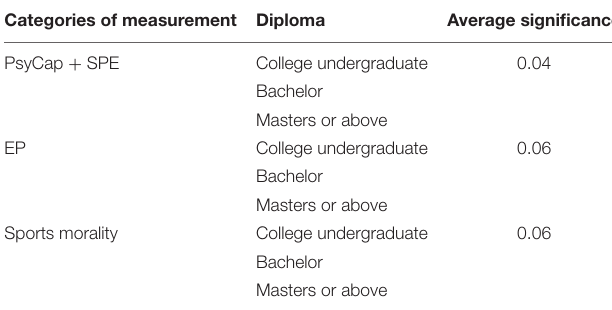
TABLE 9 | Prominent differences of different diplomas.